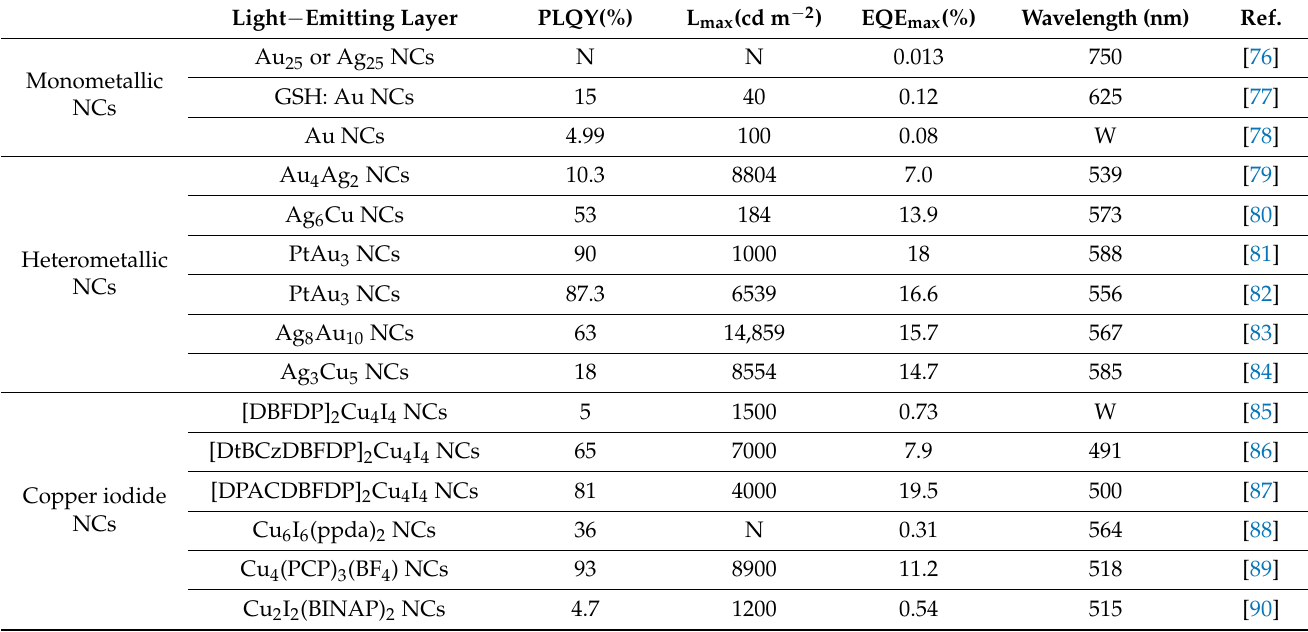
Table 2. Optical and electrical performances of the electroluminescent LEDs based on MNCs in the text. N = not reported. W = white